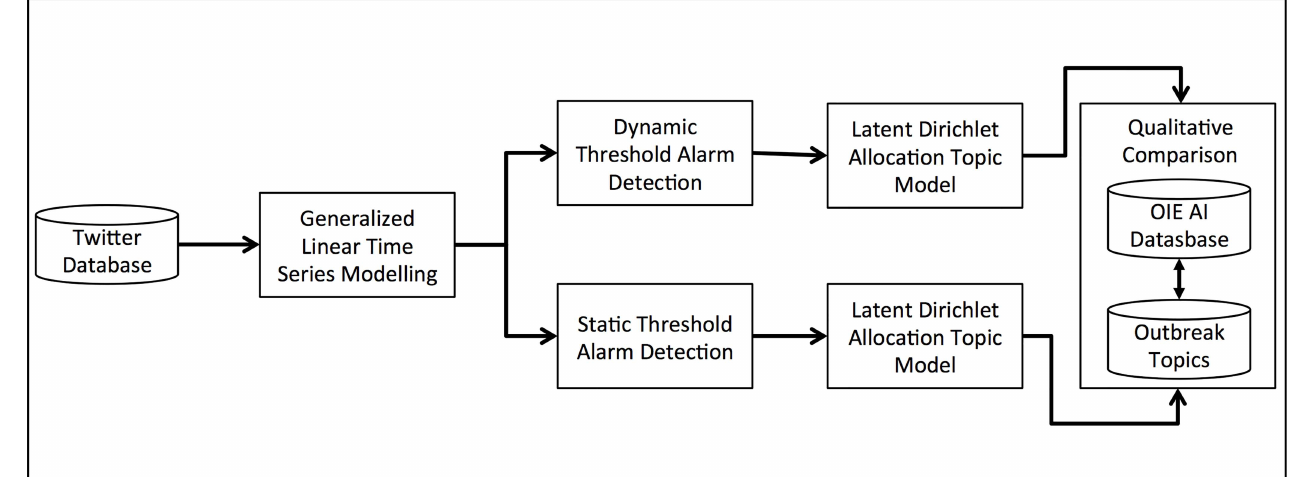
Fig 2. Data modelling, outbreak detection, and natural language processing